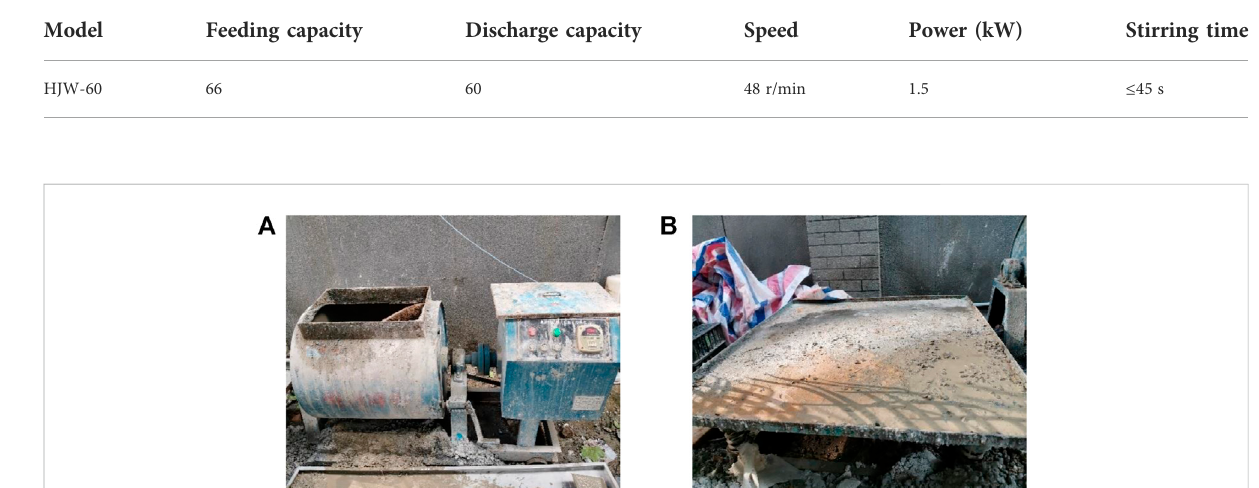
TABLE 13 Main properties of single horizontal axle forced concrete mixer.